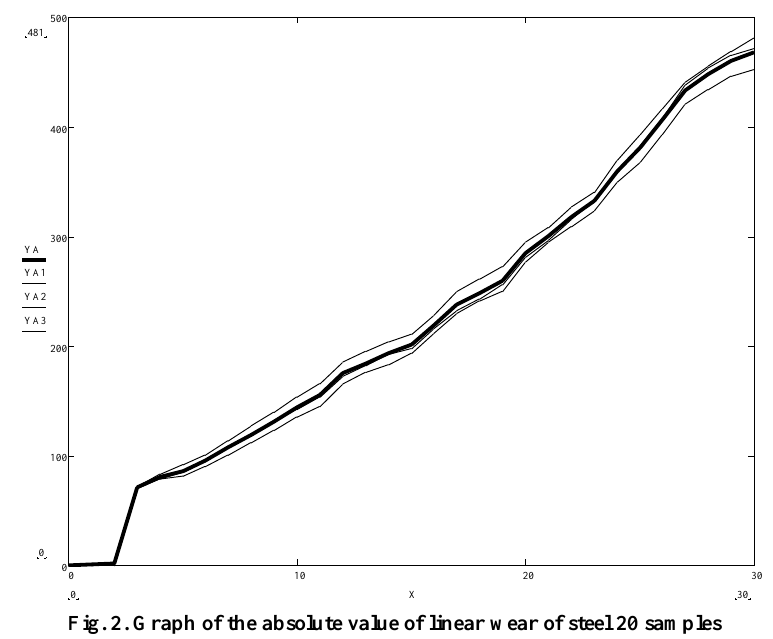
Fig. 2. Graph of the absolute value of linear wear of steel 20